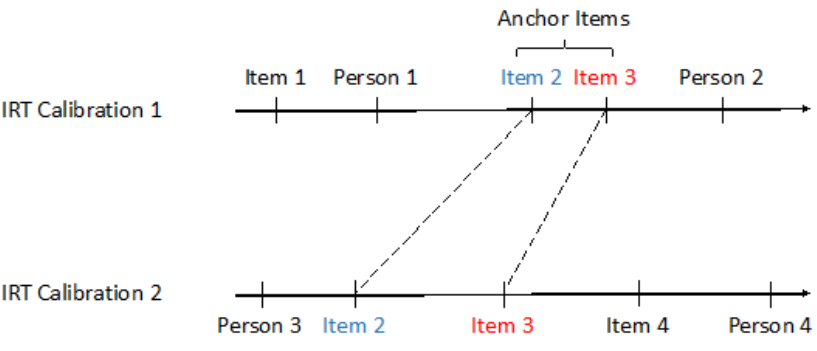
Figure 2. Illustration of two separate IRT calibrations having their own